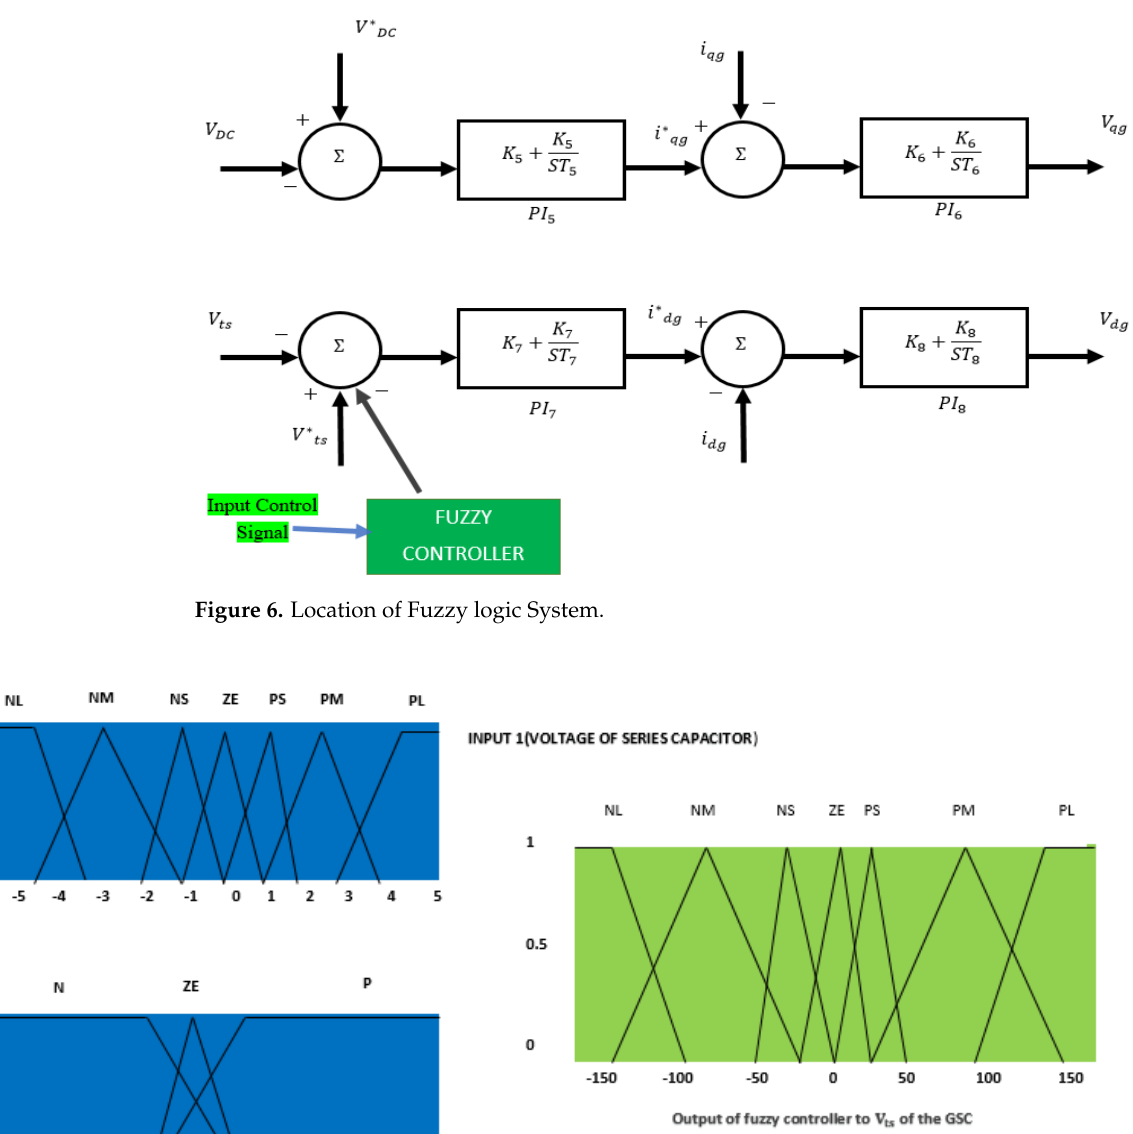
Figure 6. Location of Fuzzy logic System.